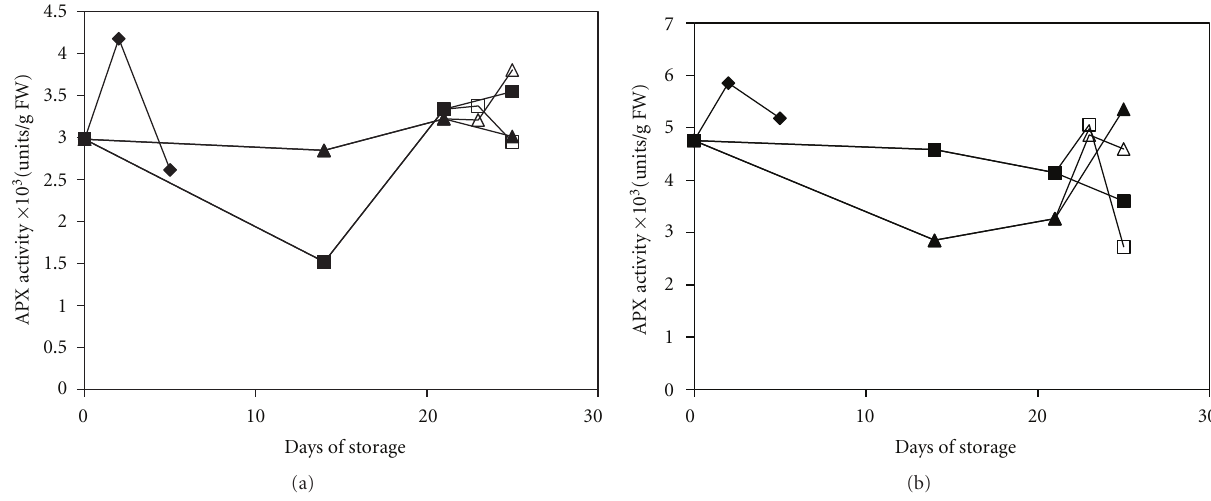
Figure 5: Changes in the APX activity of mature green peppers (a) and fully ripe/red peppers (b) for the UCRT ( (cid:2) ), MAP ( (cid:3) ), and MAP+1- MCP ( (cid:4) ) treatments during storage at 10 ◦ C; MAP ( (cid:5) ) and MAP+1-MCP ( (cid:6) ) values for the fruits transferred to room temperature at day 21. The values are the means of six replicate samples, and their S.E.s are shown.